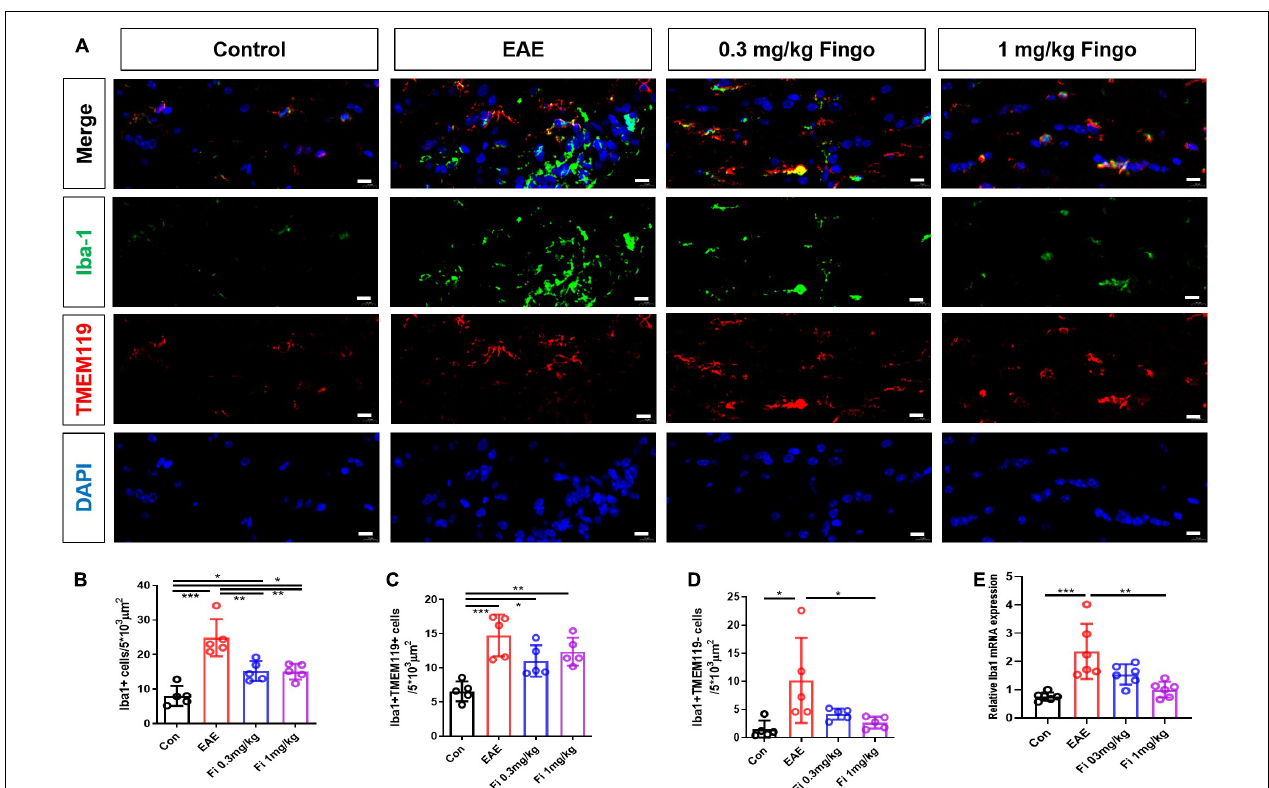
FIGURE 10 | Resident microglia and recruited macrophage numbers in the optic nerve with fingolimod treatment. (A) Resident microglia and recruited macrophages were labeled with Iba1+ TMEM119+ and Iba1+ TMEM119- in the optic nerve, respectively. (B) Comparison of microglia and macrophage numbers among groups in the optic nerve (area = 5 × 10 3 µ m 2 ). (C) Comparison of microglia numbers among groups in RGL (area = 5 × 10 3 µ m 2 ). (D) Comparison of macrophage numbers among groups in RGL (area = 5 × 10 3 µ m 2 ). (E) Iba1 mRNA expression in retina. Values are mean ± SD. One-way ANOVA plus Tukey’s multiple comparisons. * P < 0.05, ** P < 0.01, *** P < 0.001. Scale bar = 5 µ